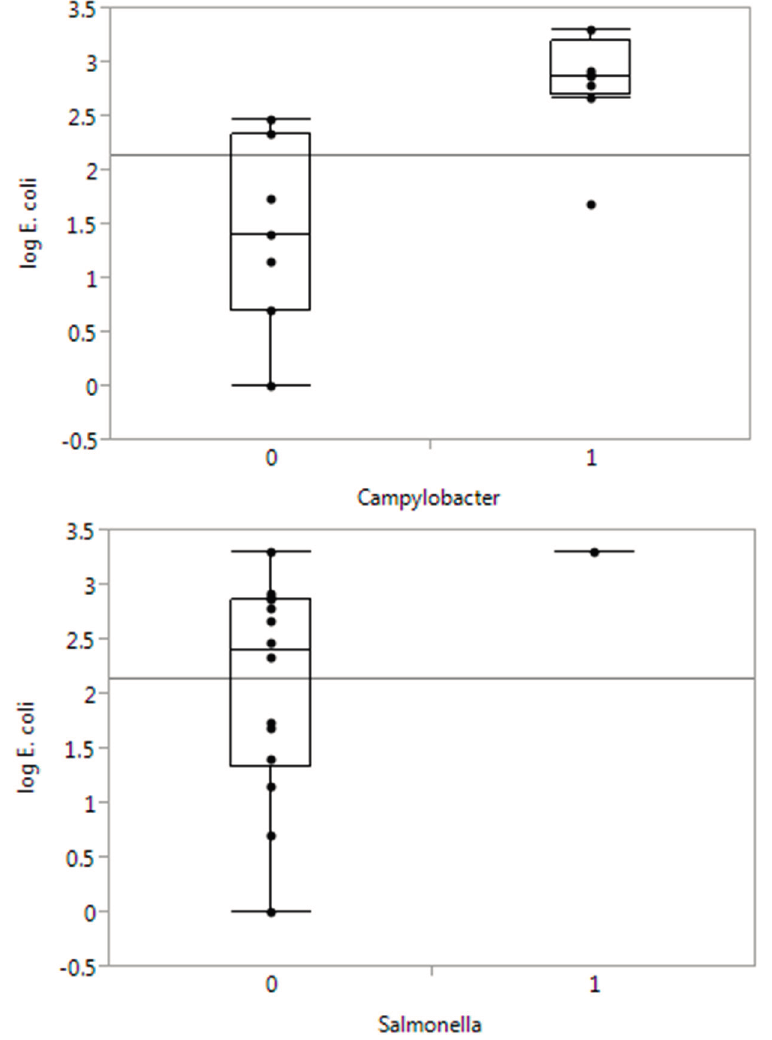
Figure 2. Boxplots of E. coli counts (log 10 MPN/100 mL water) by absence ( 0 ) or presence ( 1 ) of Campylobacter or Salmonella in water samples. The horizontal line shows the overall mean